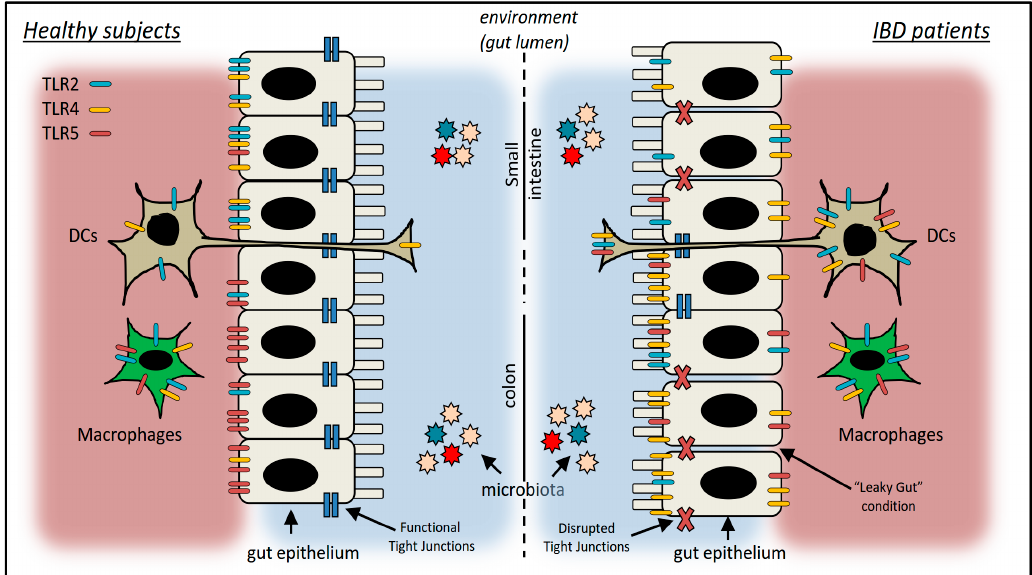
Figure 1. Schematic representation highlighting the expression of Toll-like receptors (TLRs) in the gastrointestinal tract (GIT) of healthy subjects and patients with inflammatory bowel disease (IBD). The gut epithelium represents the interface between the microbial ecosystems present in the lumen of the GIT and the immune system. In healthy conditions, the barrier function of the gut epithelium is guaranteed by the tight junctions between the cells. In pathological conditions, these junctions are disrupted, exposing their basolateral receptors to potentially pathogenic ligands (“Leaky Gut” condition). TLR2, TLR4, and TLR5 are expressed on the gut epithelium cells, as well as on cells of the immune system (here represented only by macrophages and dendritic cells (DCs)). The localization of the specific TLRs is also indicated in the small intestine and colon specifically. Details and references are reported in the text.